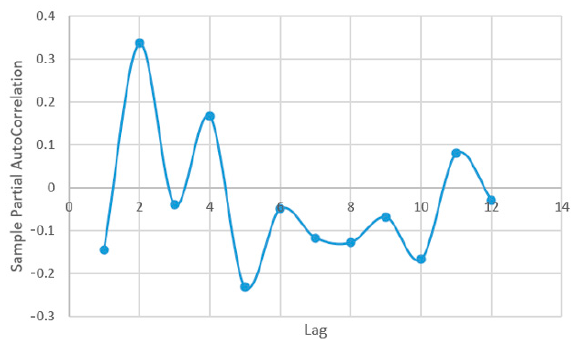
Figure A7. The AC with transformation in square roots—AR series.